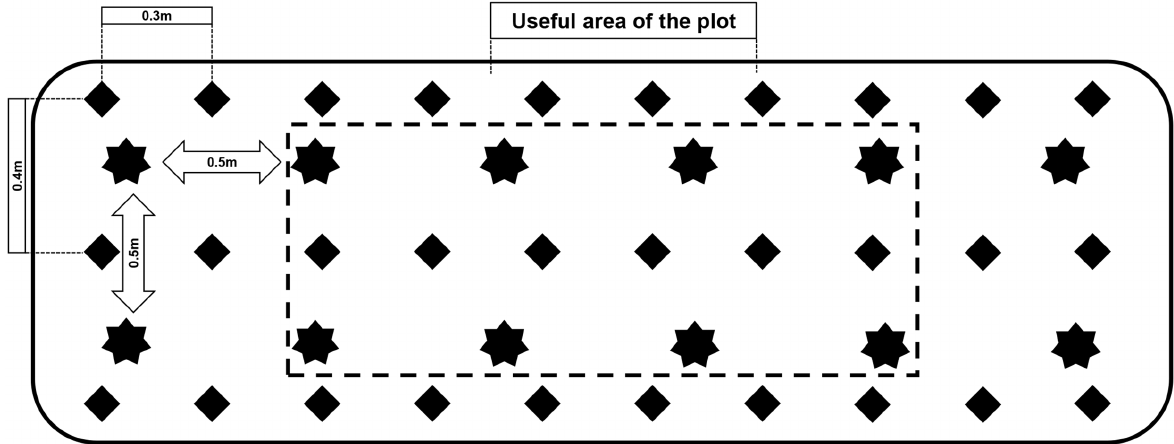
Figure 1 - Graphical representation of an experimental unit and arrangement of crops in an intercropping; kale with two lines in the center of the plot (double row, 0.5 x 0.5 m) and spinach (0.40 x 0.30